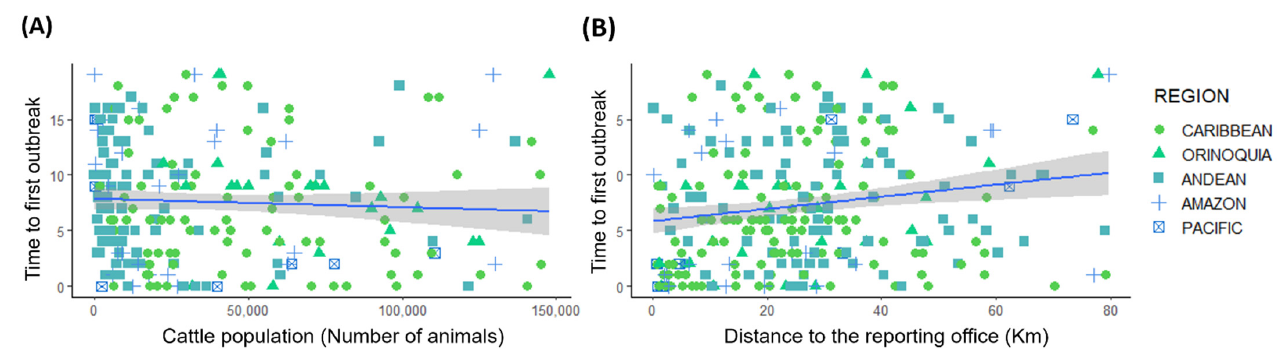
Table 1. Drivers correlated with the time to the first VBR outbreak appearance in each outbreak location: Results from a quasi-Poisson Generalized Linear Mixed Model using a Penalized Quasi- Likelihood with the glmmPQL function in R, including region as a random effect. Time to the first outbreak was not significantly correlated to the total livestock population tested in a different model instead of ‘number of cattle’ (glmmPQL: Estimate = − 1.2 × 10 − 6 , p -value = 0.12). Asterisks identified values considered as statistically significant at p -value < 0.05.